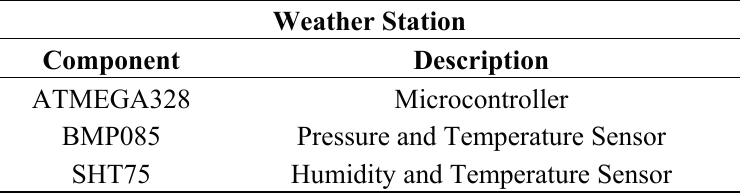
Table 7. Main components of the weather station.